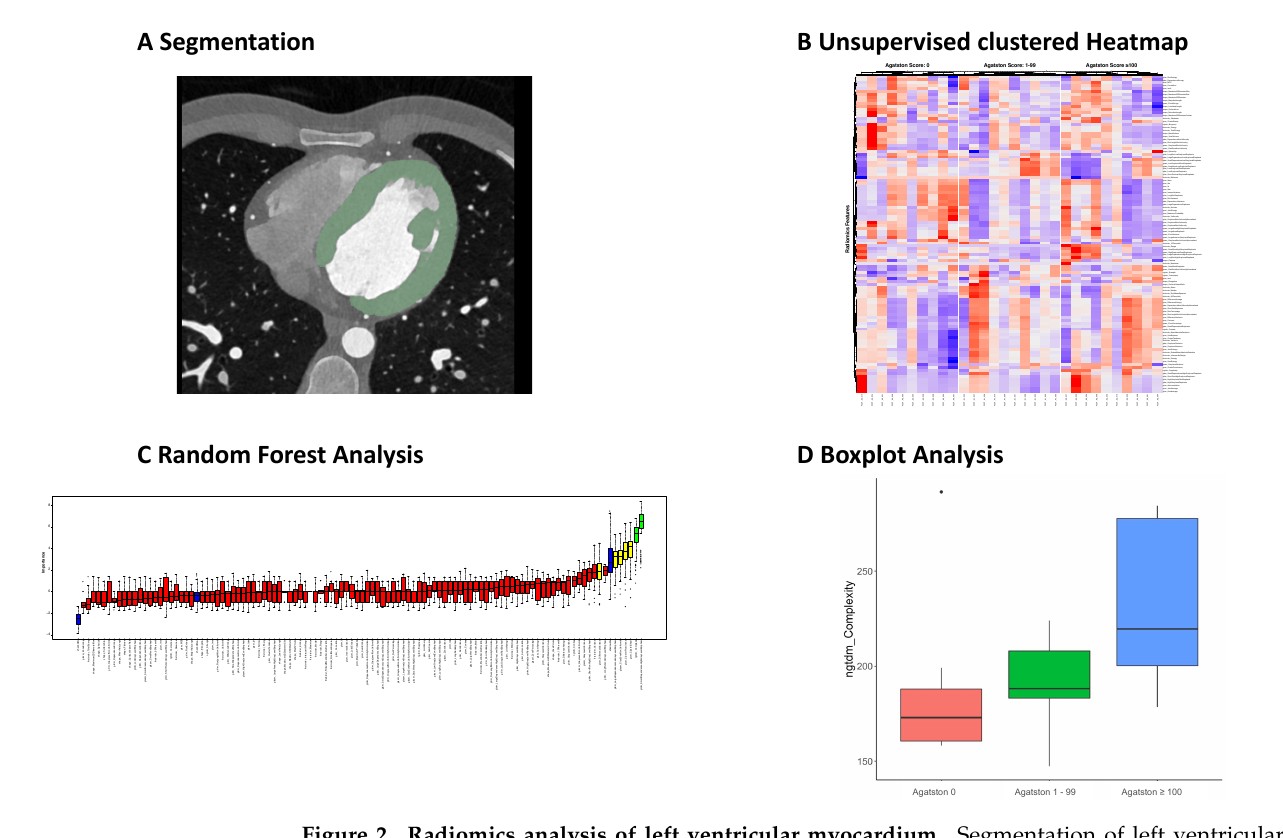
Figure 2. Radiomics analysis of left ventricular myocardium . Segmentation of left ventricular myocardium in dedicated software ( A ). Feature extraction and connection of clinical parameter (Agat- ston Score), visualized in a Heatmap ( B ). Random Forest feature selection to identify differentiating features between different Agatston Scores ( C ). Selected differentiating feature visualized in boxplot in dependence of Agatston Score ( D ). Data derived from Ayx et al.